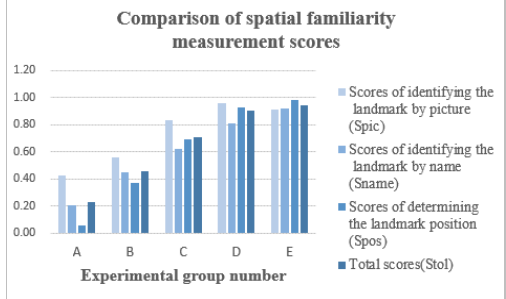
Figure 5. Comparison of spatial familiarity between groups of experimental subjects